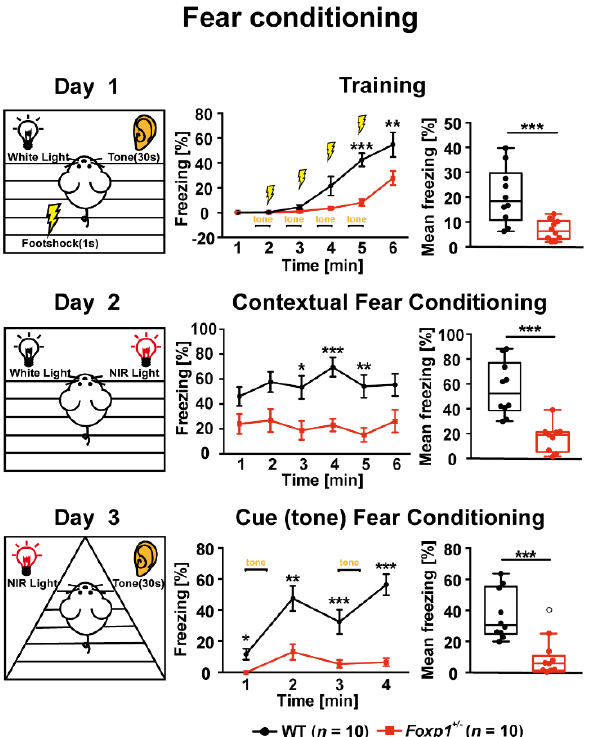
Figure 1. Fear-associated learning and memory is disrupted in Foxp1 +/− animals. In the 6 min acquisition phase (training, day 1), after the first tone/foot shock, Foxp1 +/− mice showed significantly less freezing compared to their WT littermates. Overall, mean freezing was reduced by ~67%. This was also true for contextual fear conditioning without tone and foot shock (day 2), and cued fear conditioning (day 3). In these experiments, the average freezing of Foxp1 +/− animals was decreased by ~70% and ~72%, respectively. At least ten animals were used per group. Diagrams display mean values ± SEM. In the box-and-whisker plot depicting average freezing, the boxes represent the first (lower box) and third quartiles (upper box), the whiskers represent 95% confidence intervals, and the lines within the boxes are median values. Weak outliers are marked with a circle. Asterisks indicate a significant difference (* p ≤ 0.05, ** p ≤ 0.01, *** p ≤ 0.001); two-way ANOVA; n = 10/10.